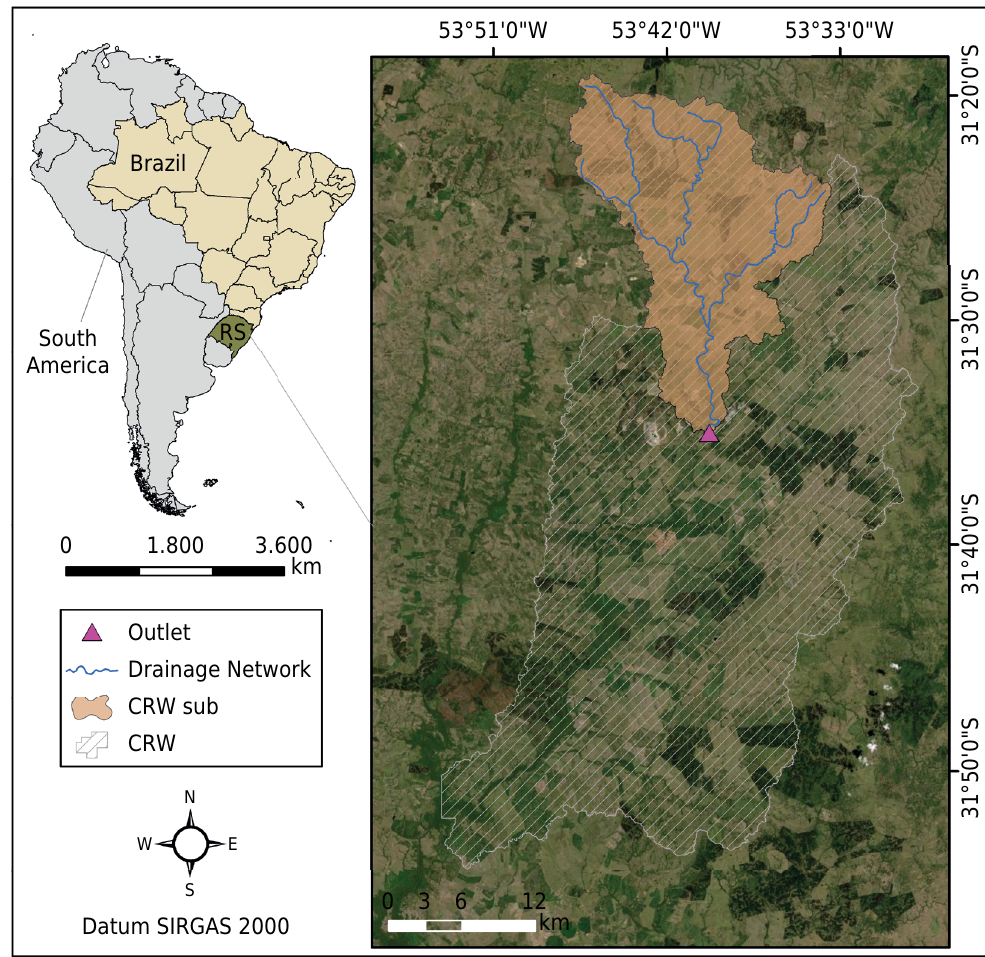
Figure 1. Location of the Candiota river watershed